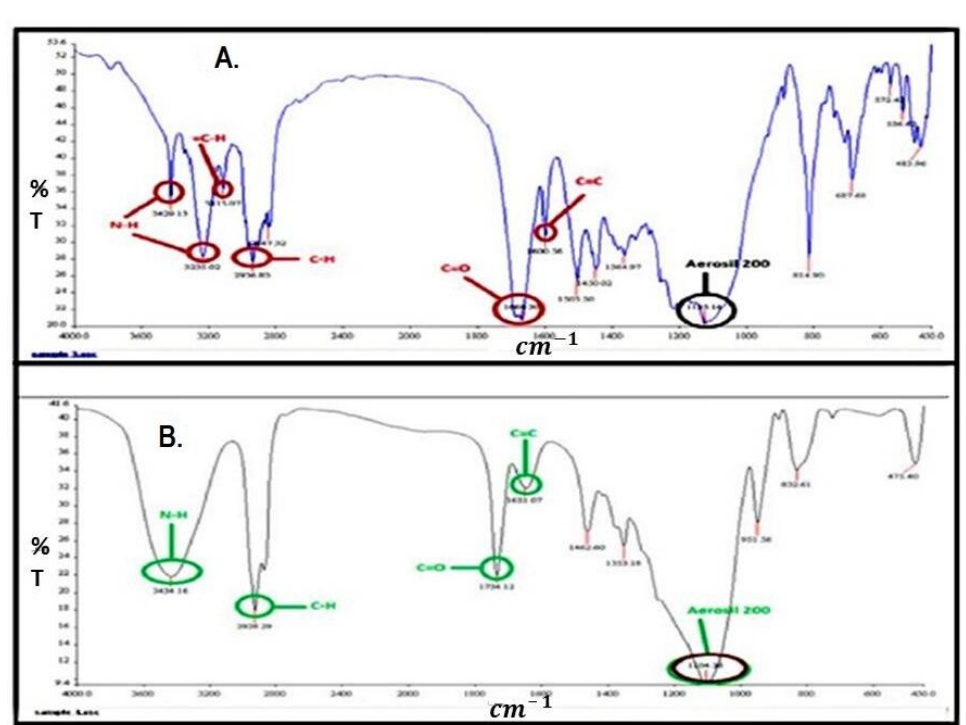
Figure 8. FTIR spectra of ( A ) Physical mixture of pure finasteride and aerosil 200 and ( B ) Finasteride S-SNEDDS powder.